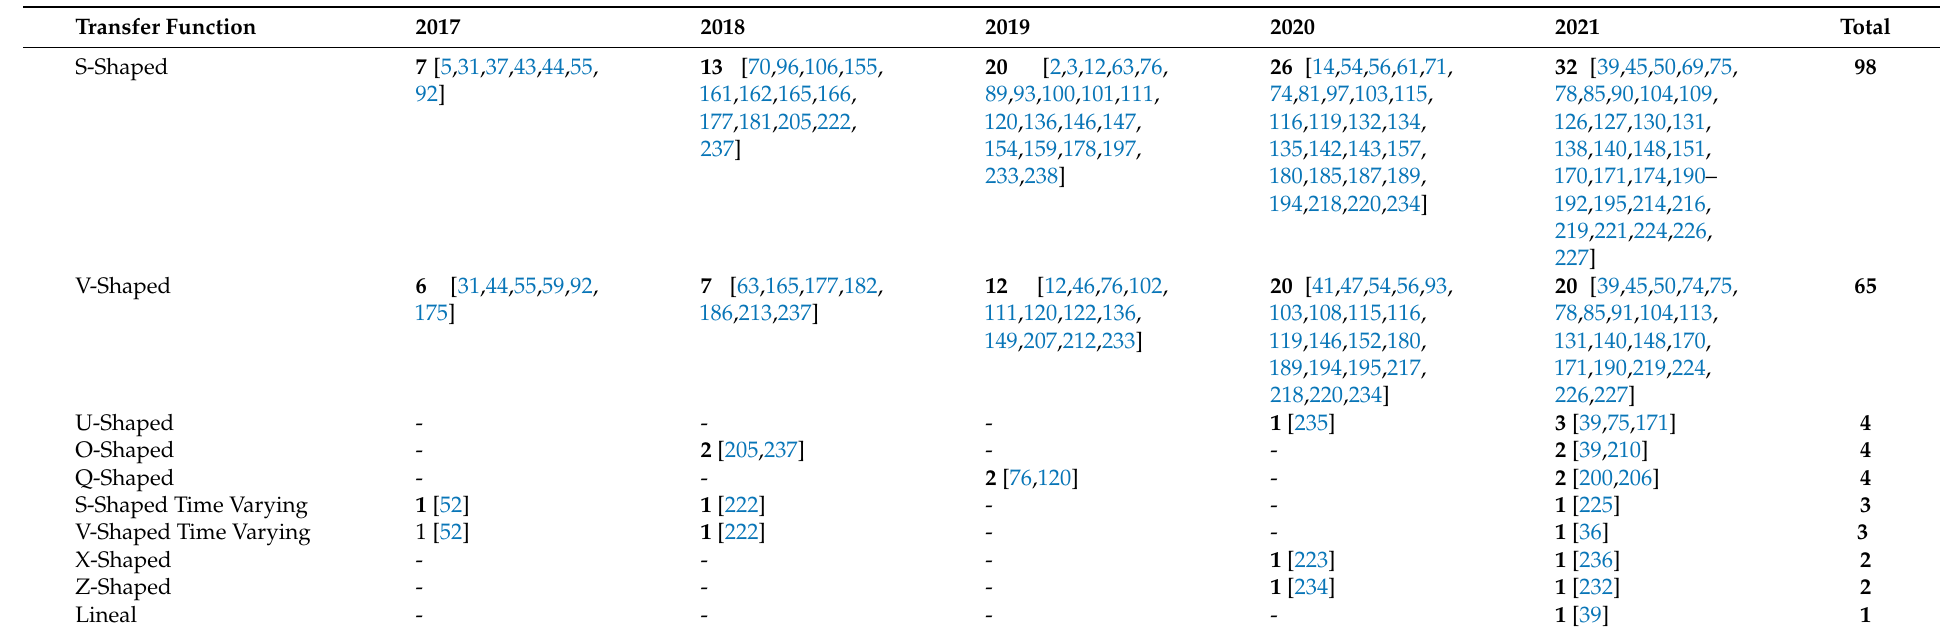
Table 8. Transfer Function per